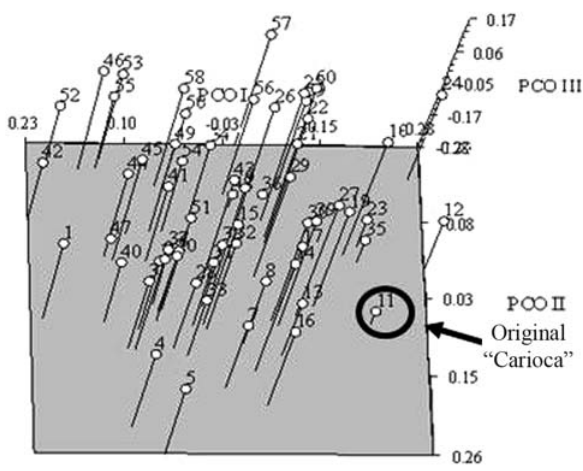
Figure 4 - Principal coordinate analysis (PCO) for the SSR data of the 60 carioca common bean accessions. The position of original ‘carioca’ is in-